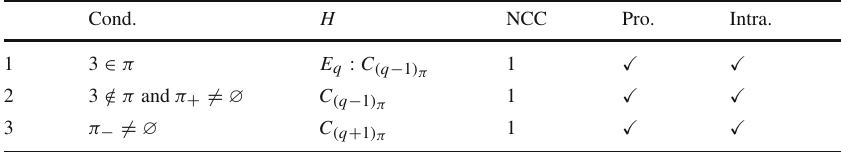
Table 4 The π -submaximal subgroups of S = L 2 ( q ) , where q = 3 p , p is an odd prime. Case: 2 ∈ π . Notation: